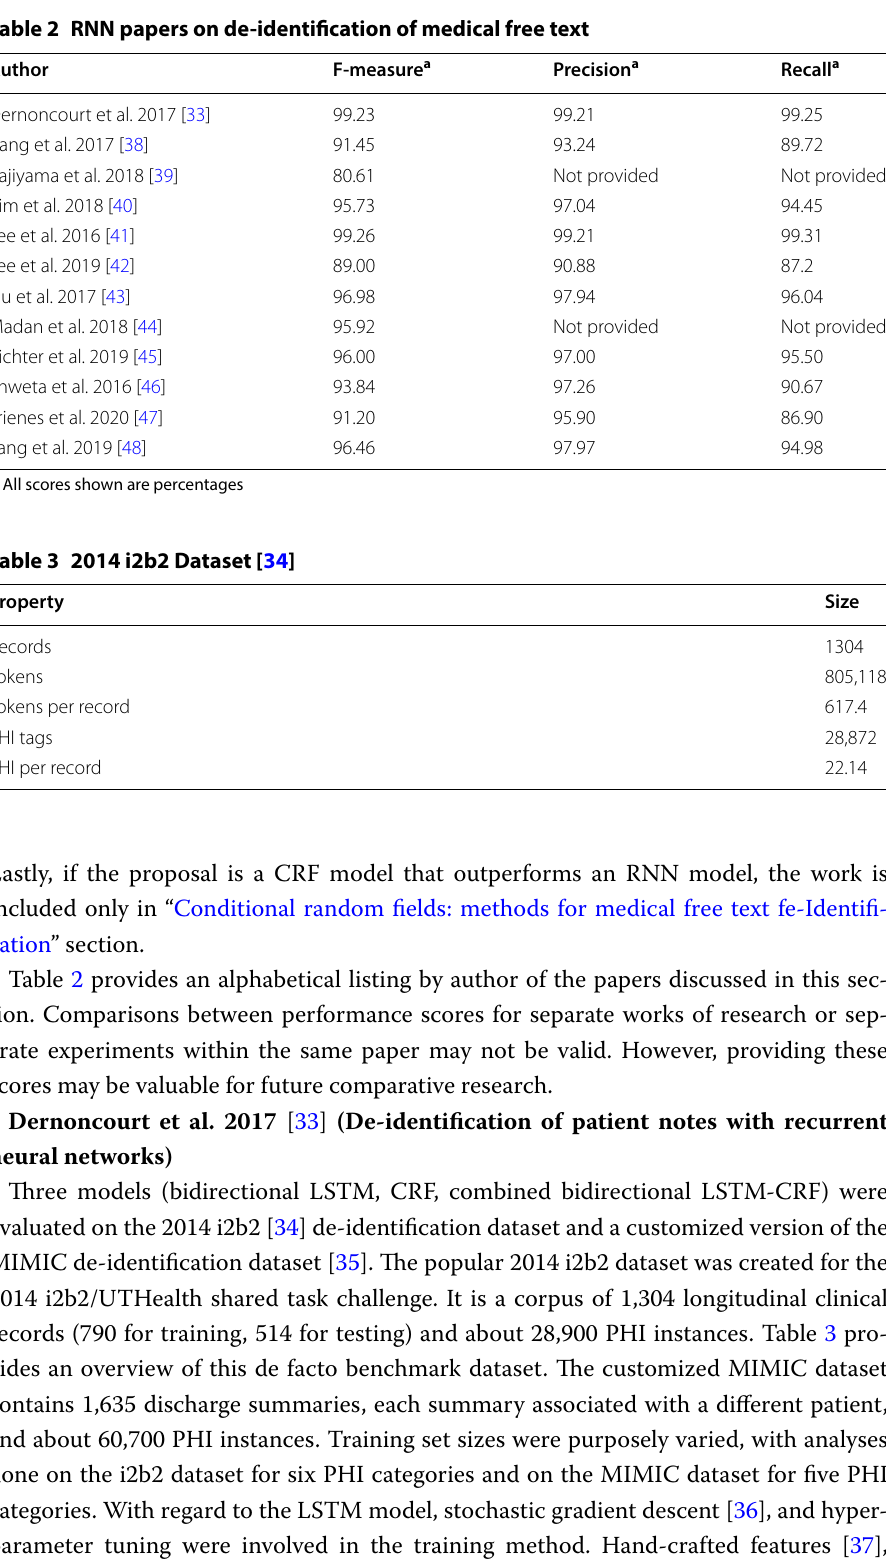
Table 2 RNN papers on de‑identification of medical free text Author